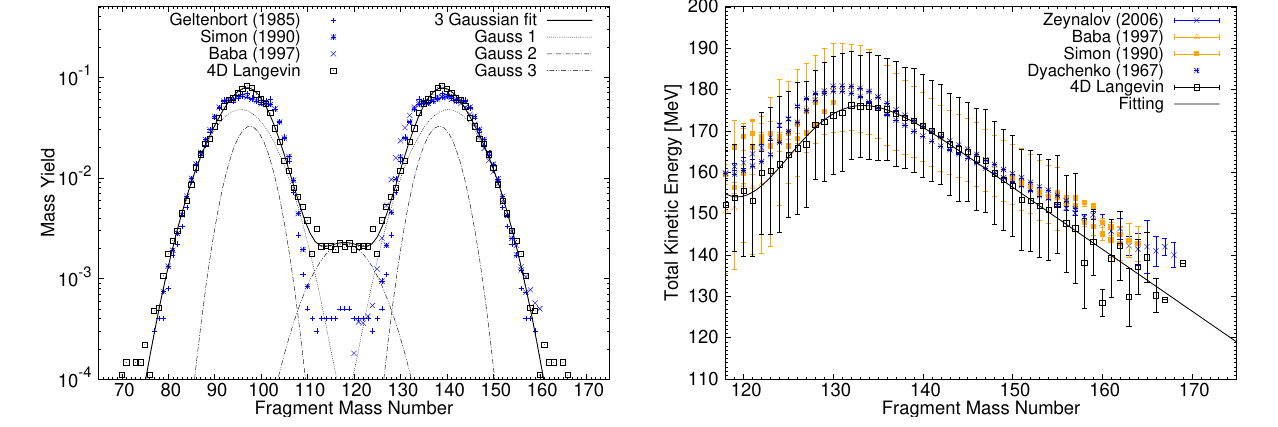
Figure 1. The three Gaussian fitted primary fission product mass yield compared with experimental data. The open squares are Langevin calculated primary fission product mass yield Y P ( A ) taken from Ref. [7] and solid line is the result of the three Gaus- sian fitting.